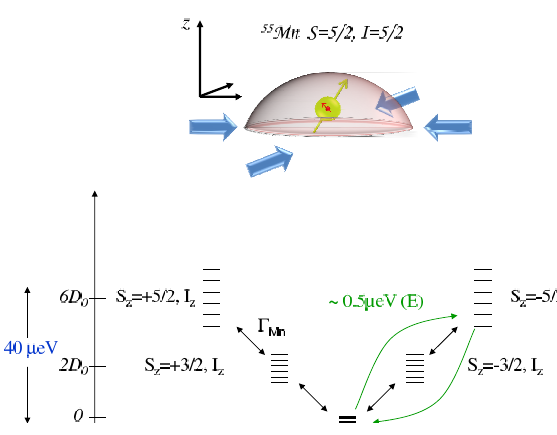
Figure 3: Scheme of the energy levels of a Mn atom in a strained II- VI QD. All the stable Mn isotopes 55 Mn carries a nuclear spin I = 5/2 which couples through hyperfine interaction (A I.S) to the electronic spin S = 5/2. The d orbital of the Mn is also sensitive to the electric field produced by the neighboring atoms (crystal field) in the zinc- blende lattice. A distortion of the lattice and consequently a change in the crystal field will also affect the d orbital. The dynamic of the Mn spin at zero magnetic field is mainly controlled by a magnetic anisotropy D 0 produced by the presence of large bi-axial strain at the Mn location. This crystal field splits the spin states of the Mn according to D 0 S 2 z . Anisotropy of the strain in the quantum dot plane (E(S 2 x -S 2 y )) also mix different S z components (green